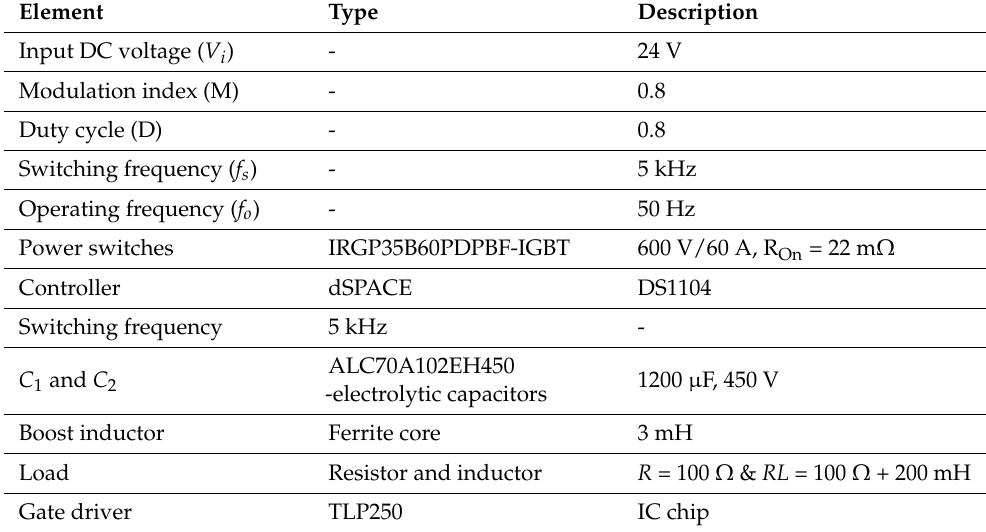
Table 3. Type and description of the parameters used in analysis and measurement.